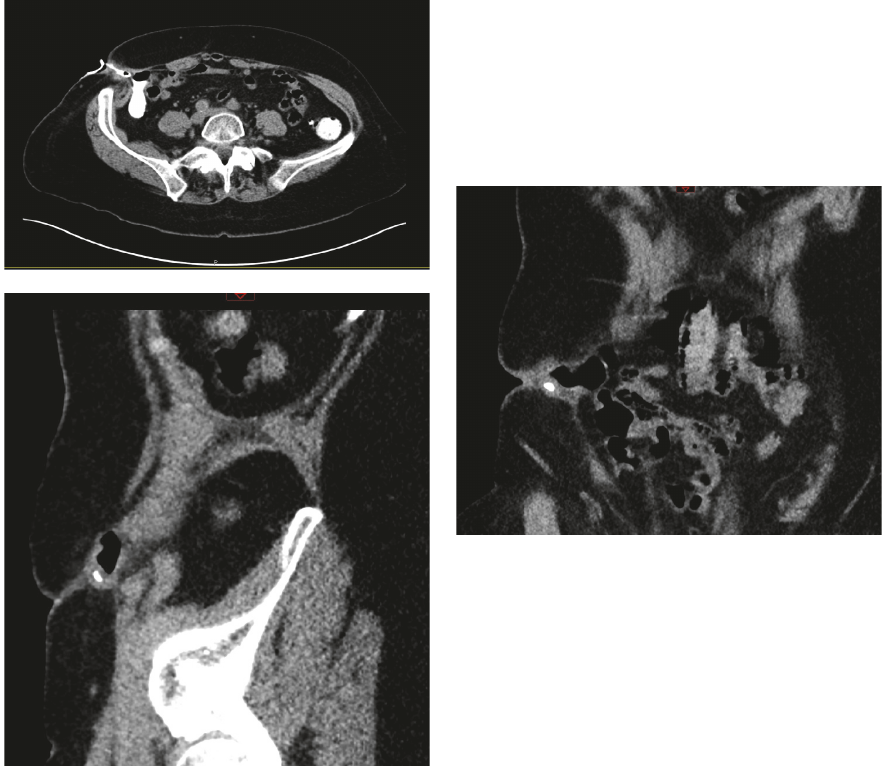
Figure 1: CT images of enterocutaneous